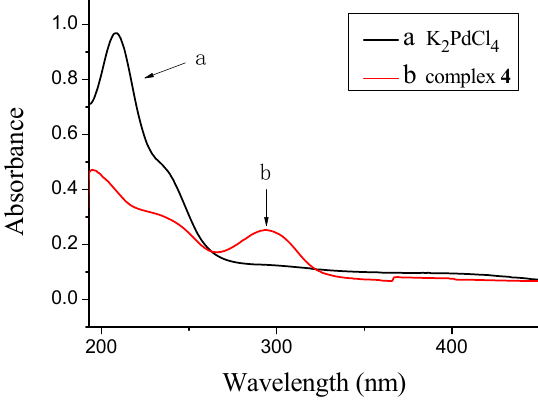
PdCl in water; ( b ) UV-vis spectra of complex 4 in 2 4